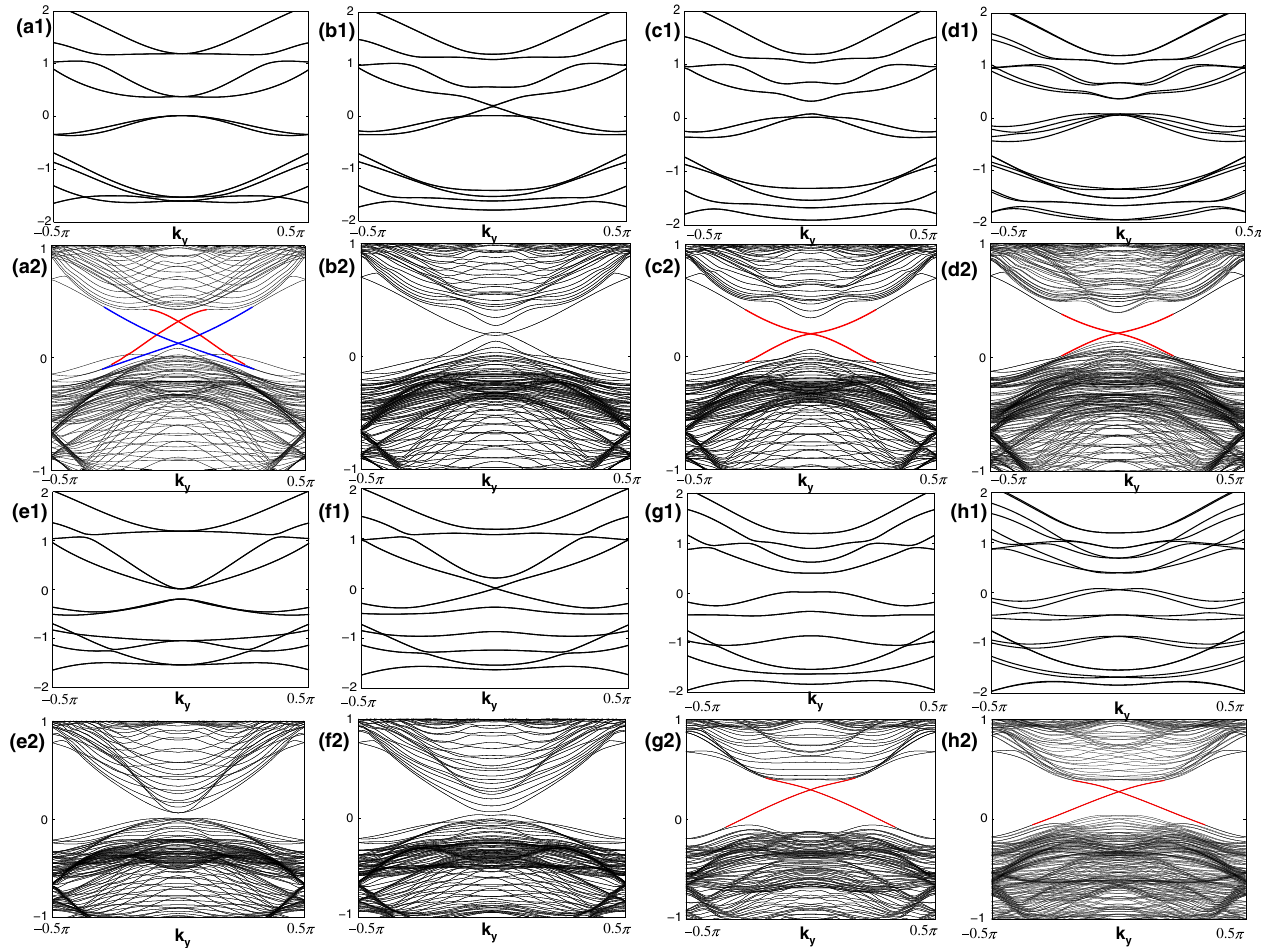
π , k ∈ ½ − ð π = 2 Þ ; ð π = 2 Þ(cid:2) for parameters ð λ o λ nn λ o ξ with the values ⊥ ; ⊥ ; ∥ ; x ¼ y s Þ